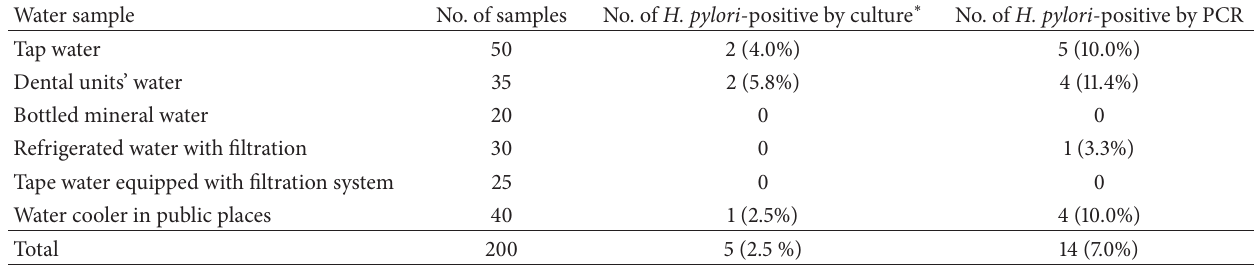
Water sample No. of